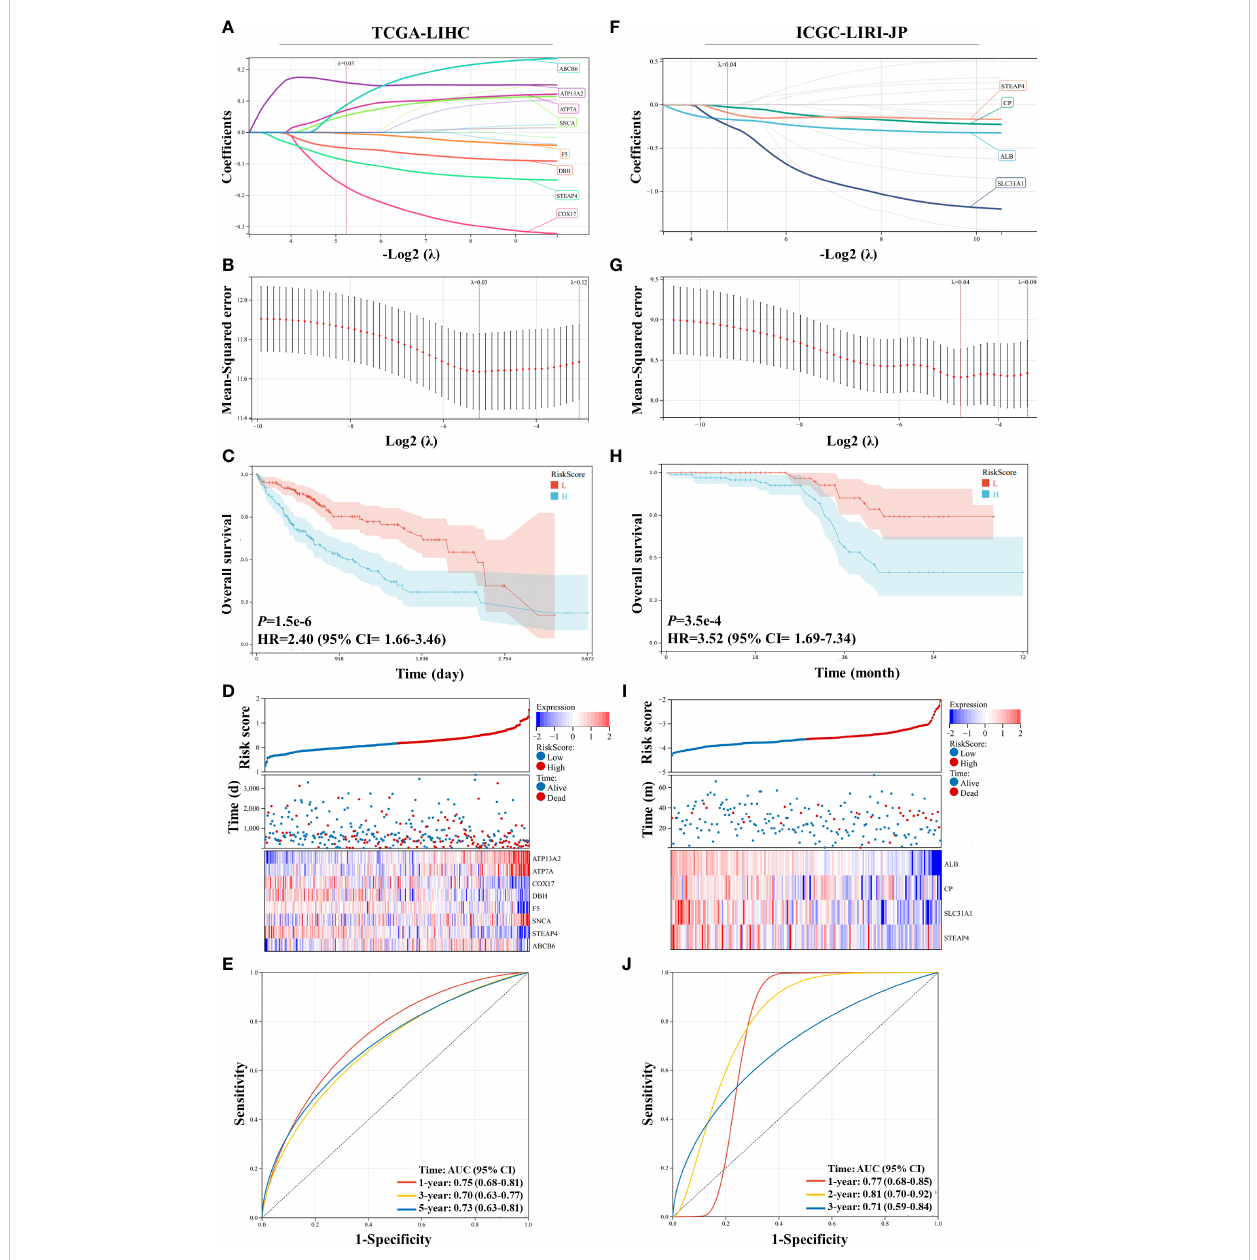
FIGURE 2 Construction and validation of the least absolute shrinkage and selection operator (Lasso) model in the TCGA-LIHC and ICGC-LIRI-JP datasets. (A, B) The Lasso regression model was constructed using 15 prognostic genes in the TCGA-LIHC dataset, and eight genes were successfully included in the model. (C) Kaplan – Meier survival analysis of patients with hepatocellular carcinoma (HCC) grouped by risk scores in the TCGA- LIHC dataset. (D) Distribution of the risk scores, survival status, and expression of eight critical predictive genes. (E) Receiver operating characteristic (ROC) curve of risk scores in the TCGA-LIHC dataset. (F, G) The Lasso regression model was constructed using 15 prognostic genes in the ICGC-LIRI-JP dataset, and four genes were successfully included in the model. (H) Kaplan – Meier survival analysis of patients with HCC grouped by risk scores in the ICGC-LIRI-JP dataset. (I) Distribution of the risk scores, survival status, and expression of four critical predictive genes. (J) ROC curve of risk scores in the ICGC-LIRI-JP